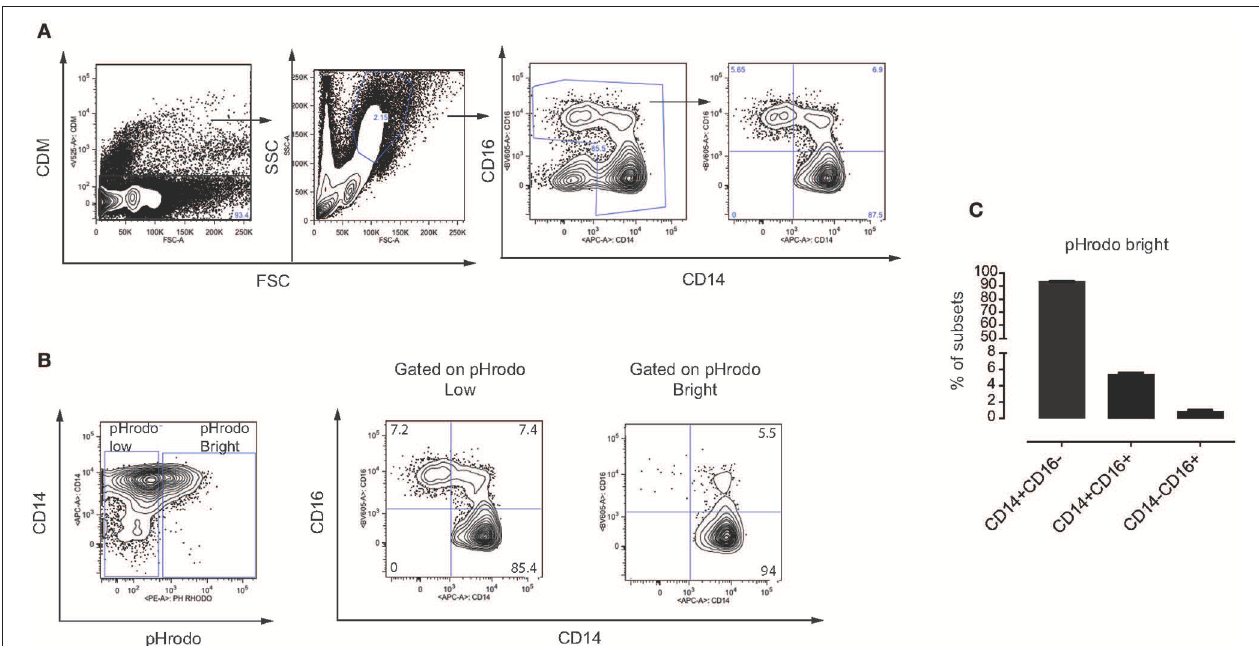
FIGURE 4 | Phagocytosis of MSC is mediated by classical and intermediate monocytes. (A) Gating strategy on different subsets of monocytes in freshly isolated PBMC. Classical monocytes (CD14 + CD16 − ), intermediate monocytes (CD14 + CD16 + ), and non-classical monocytes (CD14 − CD16 + ). (B) Representative flow cytometry plots showing distribution of different subsets of monocytes on gated pHrodo Bright and pHrodo Low. (C) Distribution of the three monocyte subsets within the pHrodo Bright population. Bars represent mean values with SD ( n = 4 PBMC) of pooled data from two different experiments.